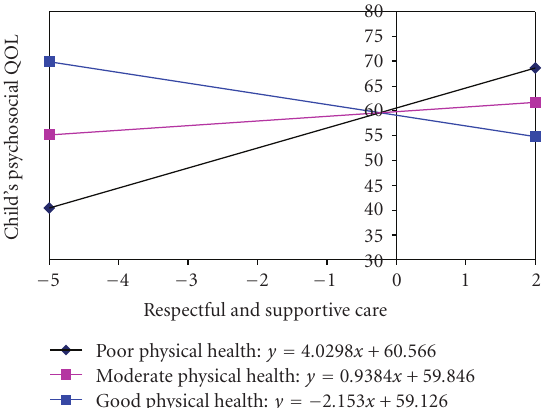
Figure 4: Interaction between Respectful and Supportive Care and PMK Physical